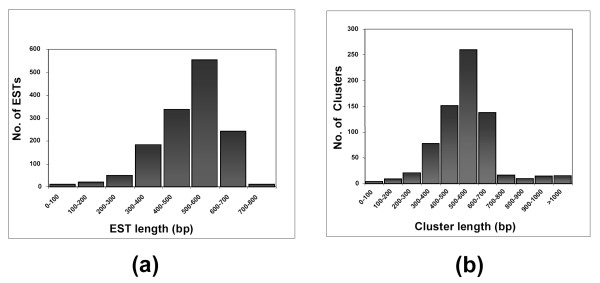
Distribution of read lengths of A. mylitta ESTs and clusters. (a) Read lengths of 1412 ESTs. (b) Read lengths of clusters.